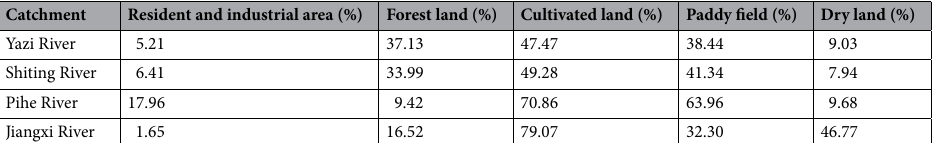
Table 2. Statistics of the land use at four sub-catchments within Tuojiang River